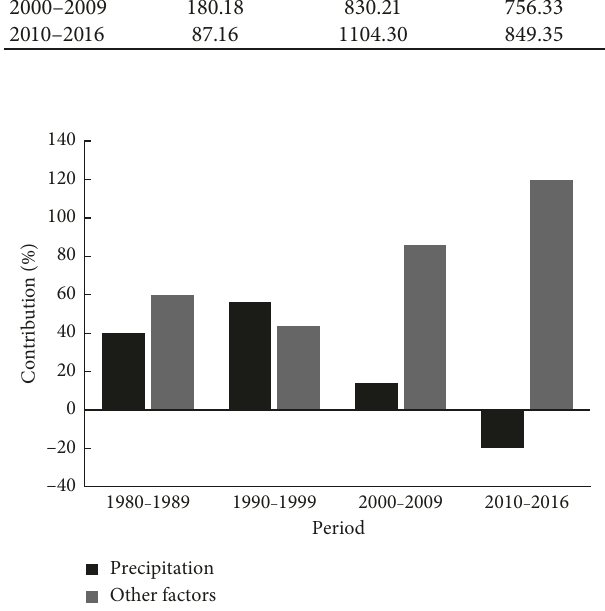
Figure 10: Contributions of precipitation and other factors to the changes in sediment yield in the HLR since